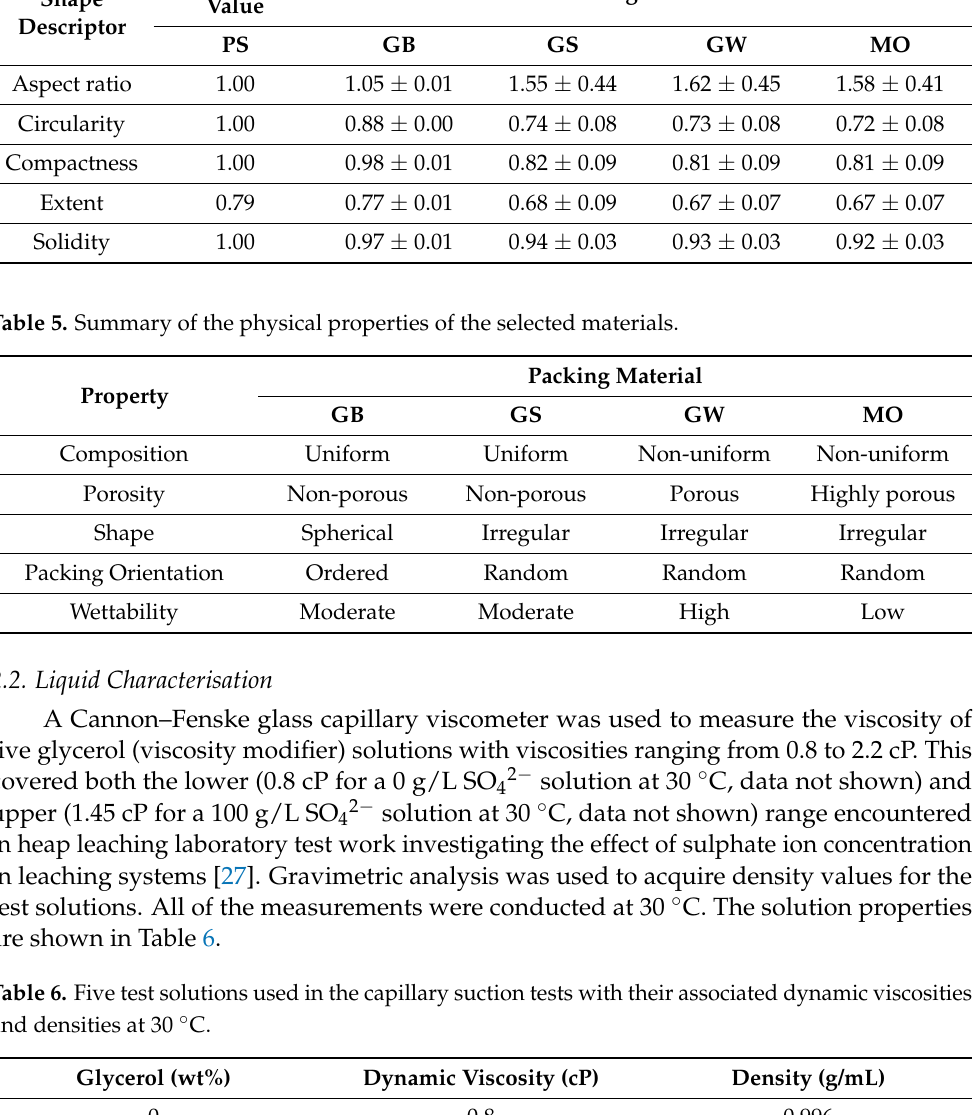
Table 4. Average and standard deviation shape descriptor values obtained for the 2 and 5 mm glass beads (GBs) and over the 1–8 mm size fraction range for the glass shards (GSs), greywacke (GW), and malachite ore (MO) materials. The values are compared to those calculated for a perfect sphere (PS). Shape Value Descriptor